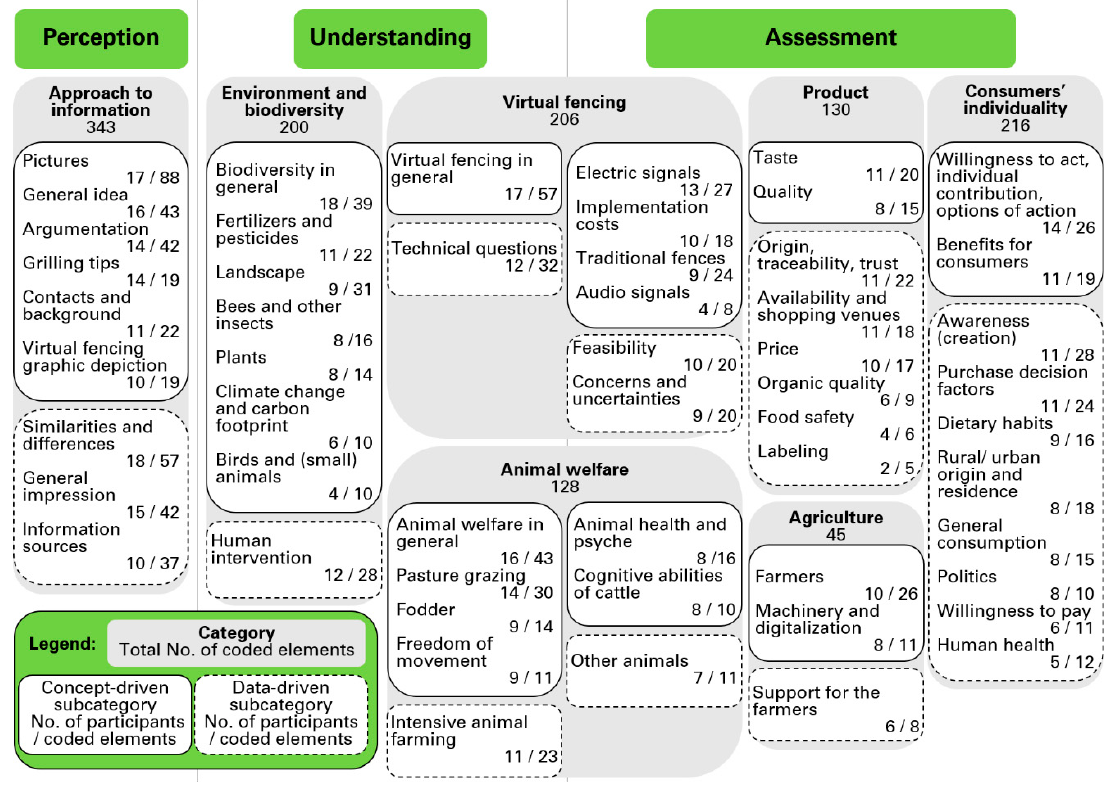
Figure A1. Coding frame: categories and subcategories in the participants’ perceptions of and associations with virtual fencing.